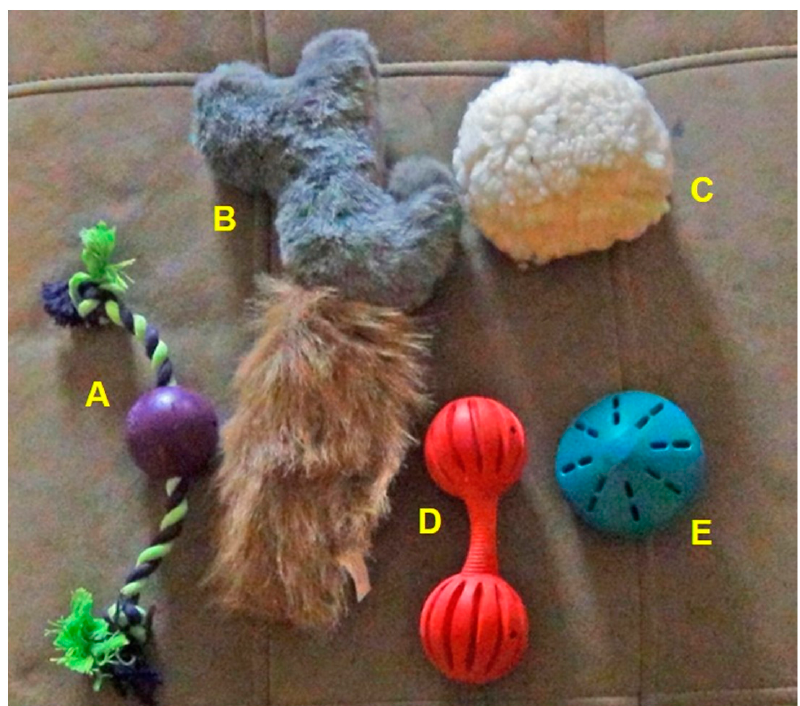
Figure 1. The 5 different PetSafe research toys (objects). These objects are labelled as seen in the figure: ( A ) a braided cloth rope attached to hard rubber ball; ( B ) a squirrel; ( C ) a white plush puff; ( D ) red rubber bar-bell-shaped bone; ( E ) and a blue hard rubber disk.